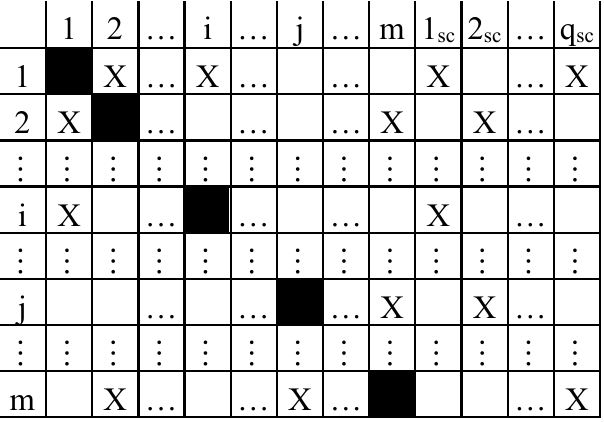
the two filled cells indicate that the pose parameters of a line, which the IC with indices given by the two row indices of the two filled cells lies on, are known. The central filling rule is that, in the first m column, an empty cell can be filled only when the data necessary